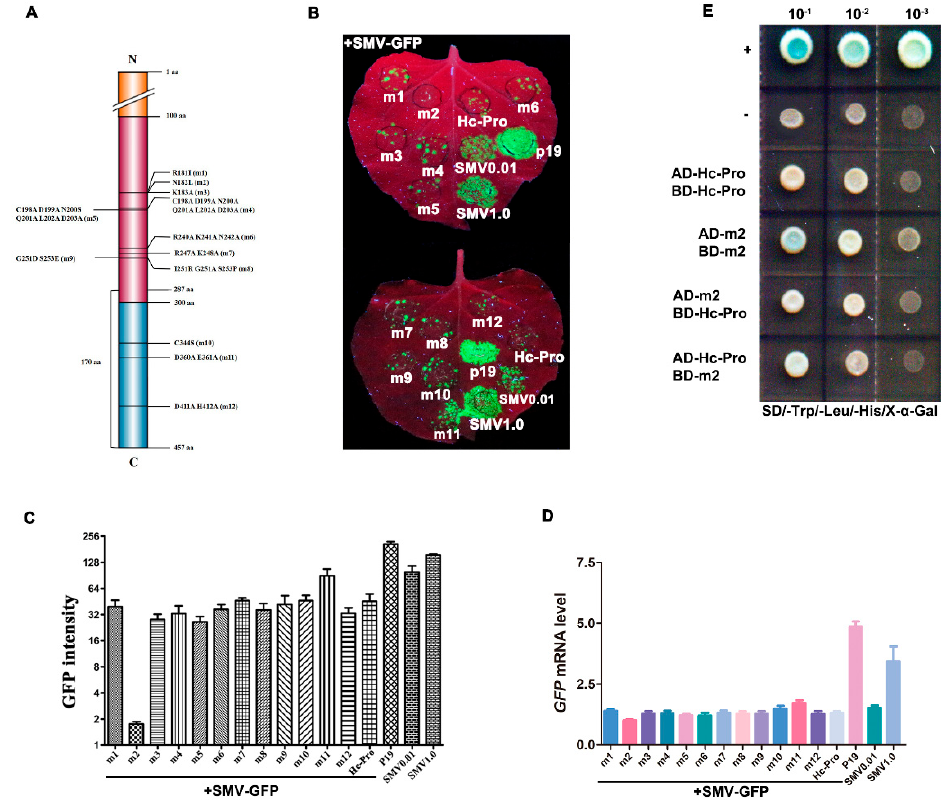
Figure 7. Functional analysis of mutant Hc-Pros. ( A ) Schematic diagram of mutation sites on Hc-Pro protein. Different colors indicate three different domains. ( B ) Effects of twelve Hc-Pro mutants on SMV-GFP infection. Each Hc-Pro mutant construct was co-infiltrated with SMV-GFP, and GFP fluorescence was visualized at 5 dpi under a UV lamp. P19 served as a positive control, and empty vector served as a negative control. ( C ) The GFP fluorescence in the infected area of 12 mutants in (B) was quantified with the Gel-Pro analysis software. ( D ) RT-qPCR detection of GFP mRNA level. (E) Detection of interactions between Hc-Pro and Hc-Prom2 by Y2H assays. The yeast cells containing indicated constructs were grown on selective medium lacking leucine, tryptophan and histidine (X- α -Gal). The yeast concentration gradients were 10 − 1 , 10 − 2 and 10 − 3 , respectively. pGBKT7-p53/pGADT7-RecT (positive control) is symbolized as ”+”, and pGBKT7-p53/pGADT7-lamin (negative control) is shown as ”–”.